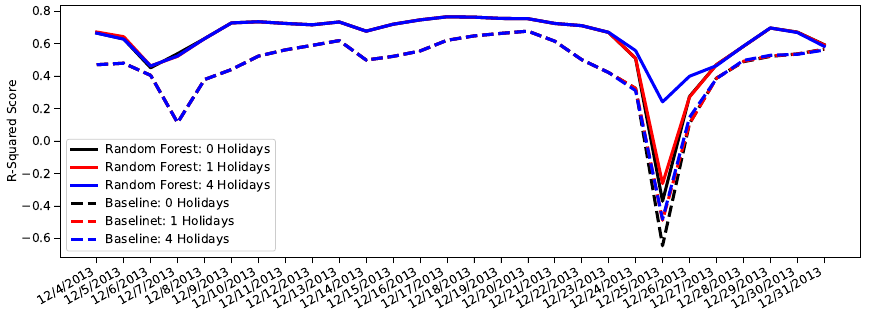
Figure 5. Next day prediction results between 4 December 2013 and 31 December 2013 using Random Forest and Baseline models trained with 0, 1, and 4 recognized